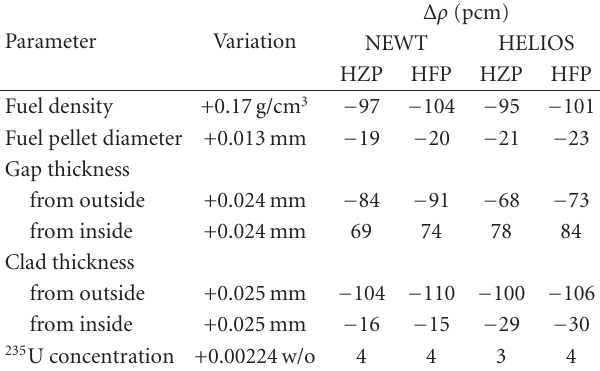
Table 11: Comparison between HELIOS and NEWT sensitivities for